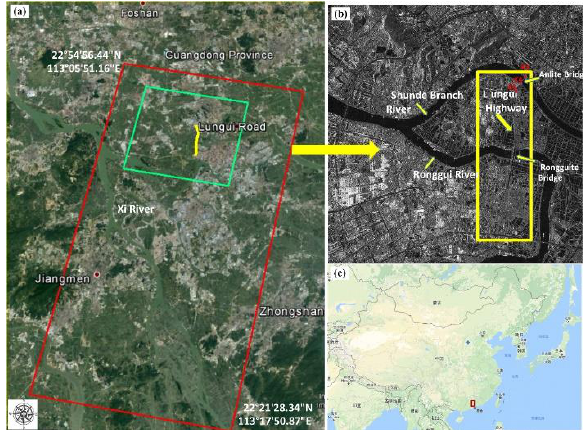
Figure 3. Study area (a) Optical image; (b) amplitude image of the area with the highway region of interest outlined in the yellow rectangle and (c) location in China